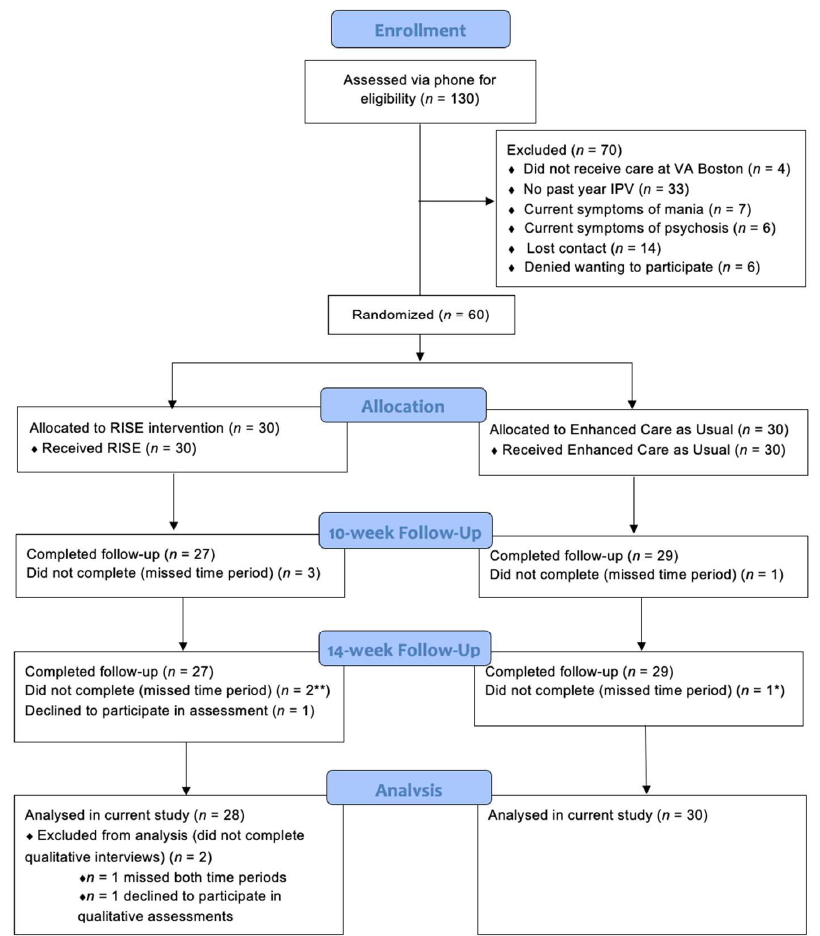
Figure 1. Participant flow through the study, including qualitative interview for analysis. Note. * In the Enhanced Care as Usual (ECAU) condition, the participant who missed the 10-week assessment was not the same participant who missed the 14-week assessment. Thus all 30 ECAU participants had interview data analyzed in the current study. ** Of the RISE participants, one of the three participants with missing data missed only one of the two assessments. Thus 28 RISE participants had interview data analyzed in the current study.